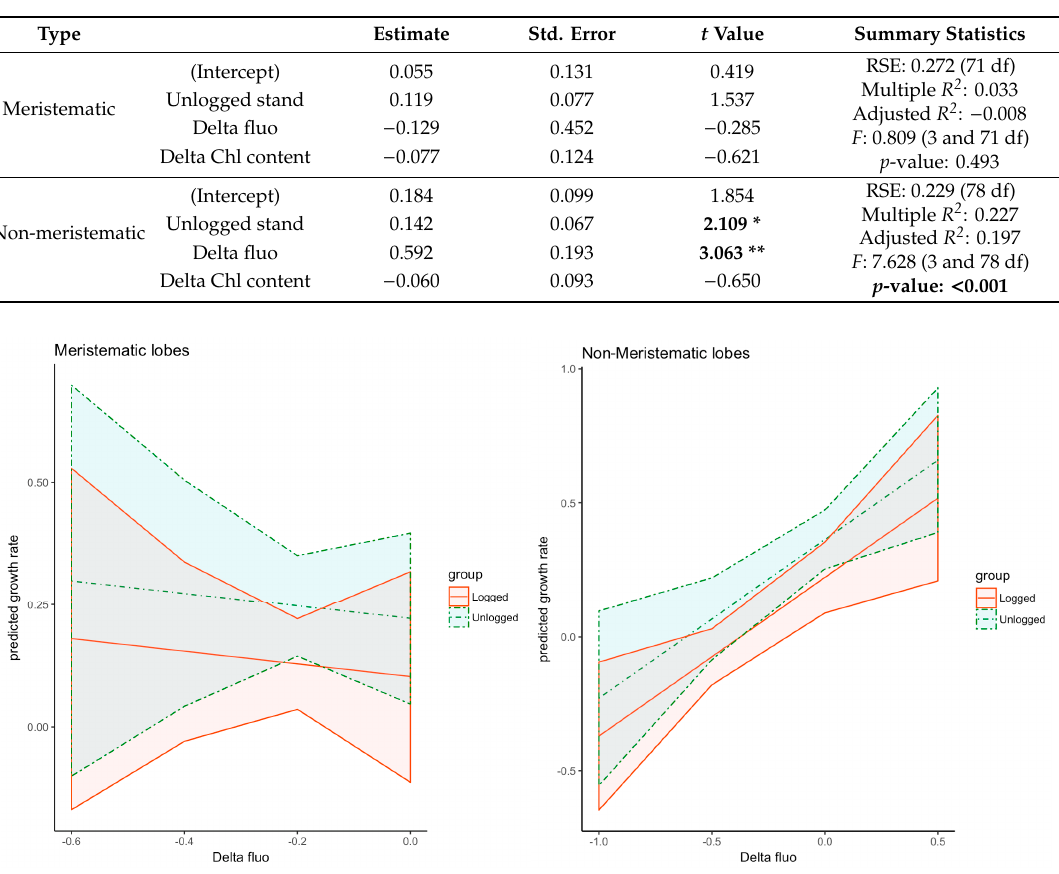
Figure 5. Fitted modeled relationships between growth rate and delta fluo, according to the linear models of Table 2, for meristematic ( left ; p > 0.05) and non-meristematic fragments ( right ; p < 0.01). Bands represent 95% confidence intervals. Solid line = logged, dashed line = unlogged.